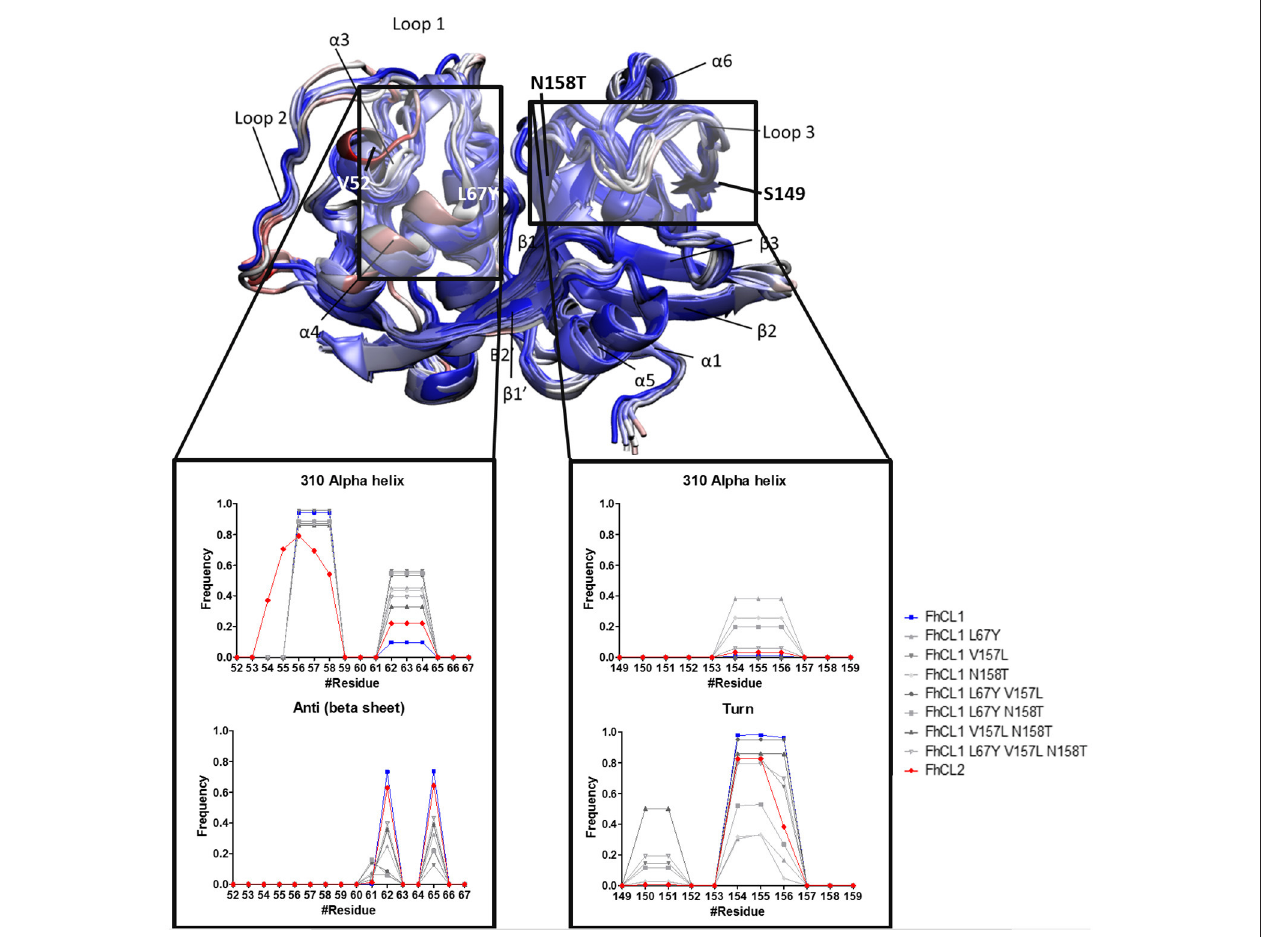
FIGURE 4 | Standardized Definition of Secondary Structure Protein (DSSP) from the S 2 and S 3 subsites, and surrounding residues. Representative structures of Fh CL1, Fh CL2 and mutants are shown in new cartoons colored by RMSD of the alpha carbon by residue. Labels indicate main components of the enzyme structure and the rectangles mark the regions analyzed in the graphics. The graphics show the frequency values obtained from DSSP for residues 52–67 (S 2 and its surroundings) and 149–159 (S 3 and its